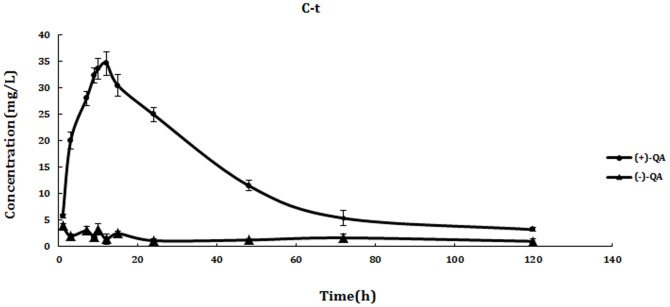
The concentration-time curves of QA enantiomers in blood after intragastric administration.Each point represents the mean ± SD (n = 6). Blood QE level was not detected through the whole study.